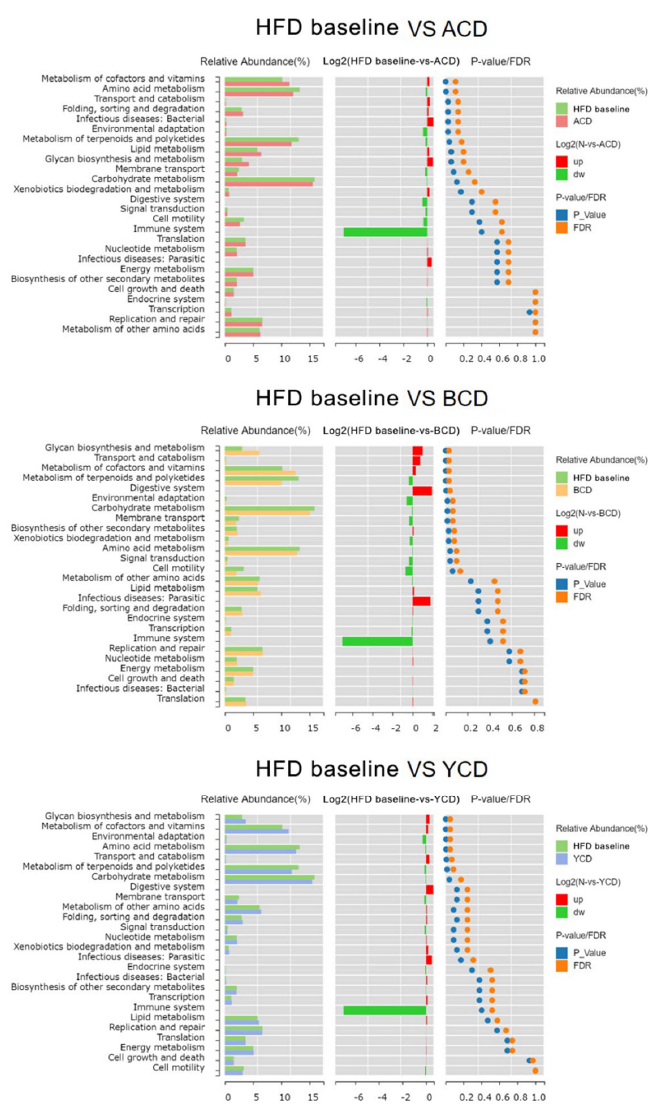
Figure 12. Effects of the three CDs on metabolism functional pathways. Control, low-fat diet; HFD baseline, high-fat diet without cellulose; fiber, high-fat diet; ACD, high-fat diet that replaced α -CD with cellulose; BCD, high-fat diet that replaced β -CD with cellulose; YCD, high-fat diet that replaced γ -CD with cellulose; n = 6.